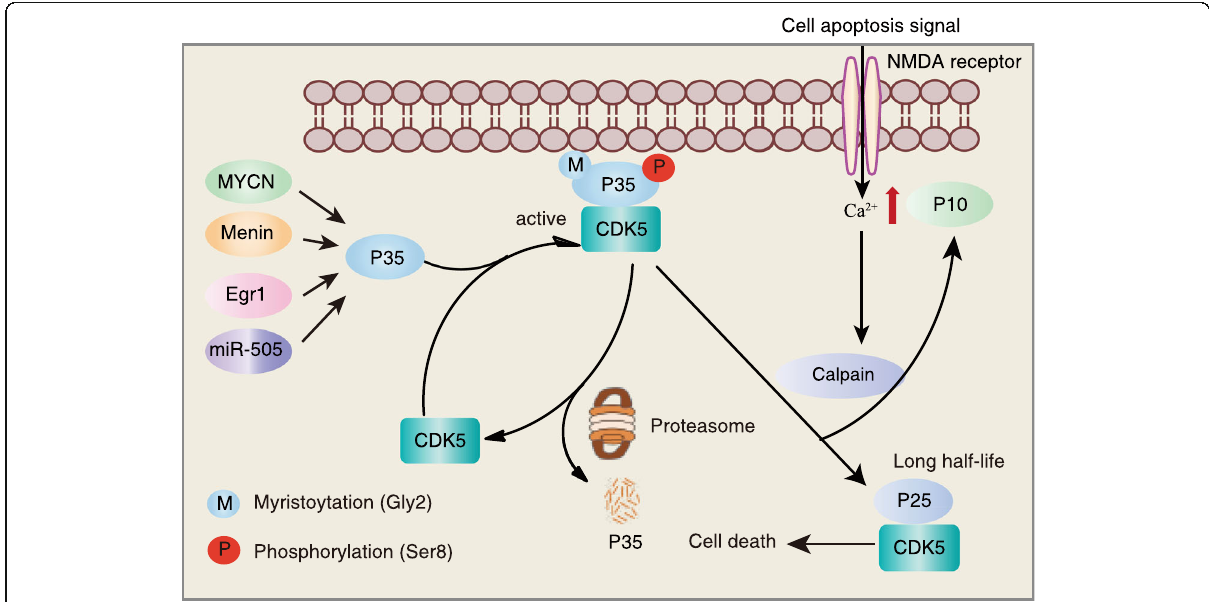
Fig. 2 The mechanism of CDK5 activation. The expression of p35 can be transcriptionally regulated by upstream regulators N-Myc, Menin, EGR1 and miR-505. Myristoylation on Gly2 of p35 determines its affinity to cell membrane, which signals for proteasomal degradation. Activated CDK5 phosphorylates p35 on Ser8 to sustain its cytoplasmic localization. When the cell faces with the death signal, the N-methyl-D-aspartate (NMDA) receptor on the cell membrane can be activated, enhancing the uptake of calcium for calpain activation. Calpain has proteolytic activity to cleave p35 into p25 fragment, a more stable protein than p35. This cleavage leads to the translocation of CDK5/p25 complex into the nucleus and prolongs the activation time of CDK5, which induces the pathological signal pathway of cell